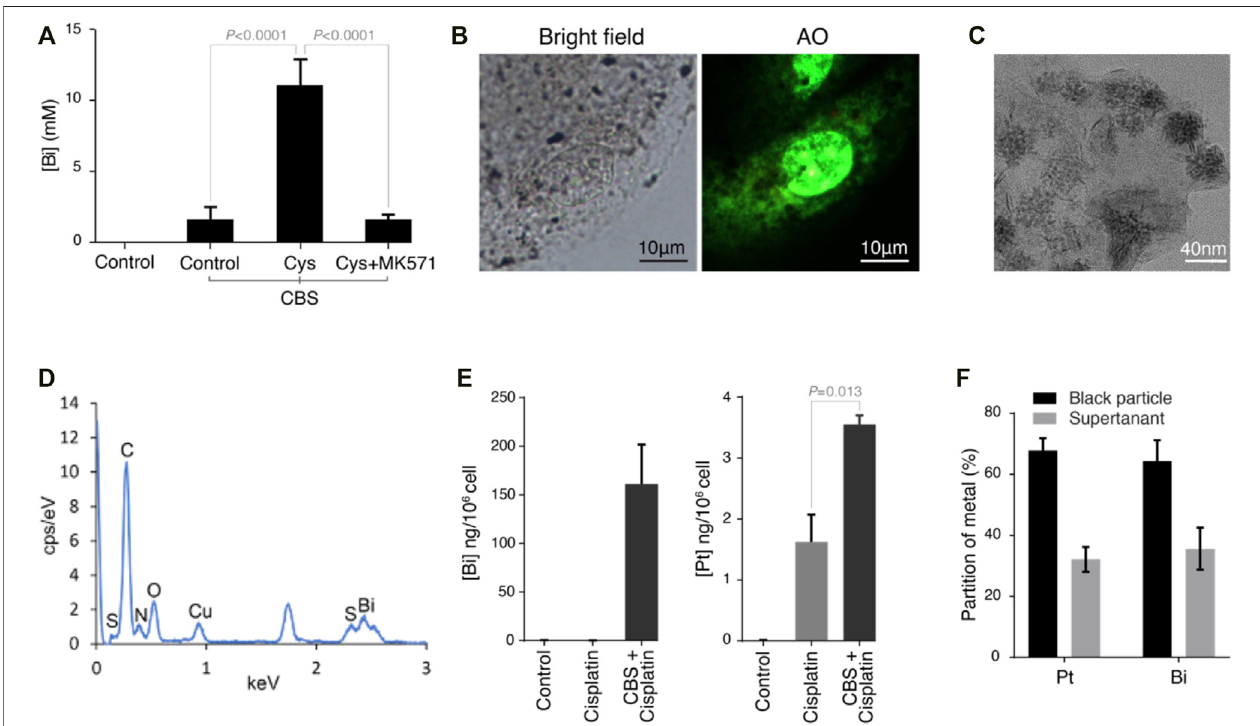
FIGURE5| BismuthenhancestheGSH-mediatedvesicularsequestrationofcisplatininHK-2cells. (A) BismuthlevelsinHK-2cellstreatedwithcontrol,CBS,CBS withcystinesupplement(~0.1 mg/ml),andCBSwithcystinesupplementandMK571. (B) Bright- fi eldand fl uorescentimagingofHK-2cellstreatedwith500 μ MCBSfor 48 h with cystine supplement. HK-2 underwent readily observable darkening. Acridine Orange (AO, 0.5 μ M for 30 min) was used to provide background illumination; numerous black particles were thus visualized under a fl uorescence microscope. (C) Transmission electron microscopy (TEM) images of black particles isolated from CBS-treated HK-2 cells. (D) Element identi fi cation of black particles using energy-dispersive X-ray spectrometry (EDS), and the element composition is shown in Table 1 (E) CBS pretreatment of HK-2 cells (500 μ M for 48 h) increased cisplatin absorption. (F) More than 60% of both platinum and bismuth are incorporated into black particles in CBS-treated HK-2 cells. HK-2 cells were pretreated with 500 μ M CBS for 48 h prior to 20 μ M cisplatin cells for 24 h.